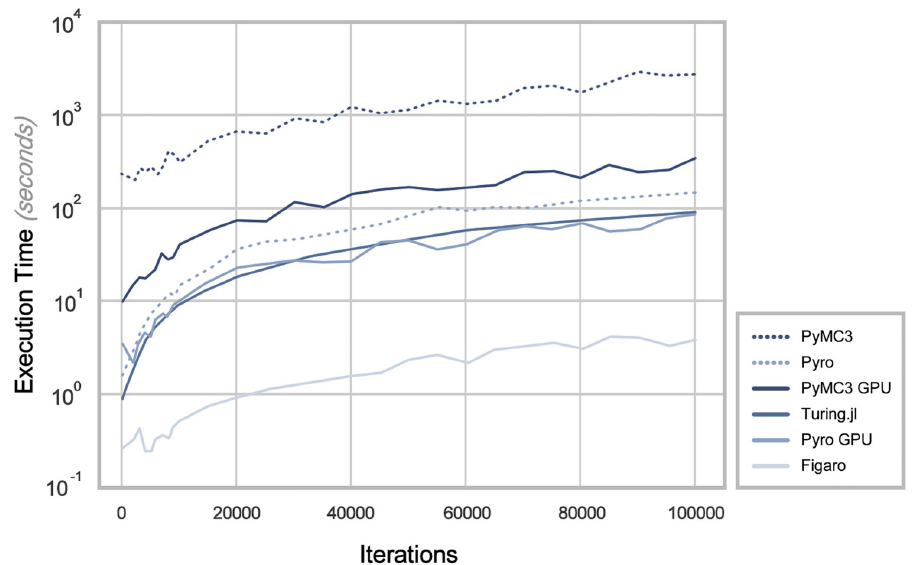
Fig 8. Execution time of EPR